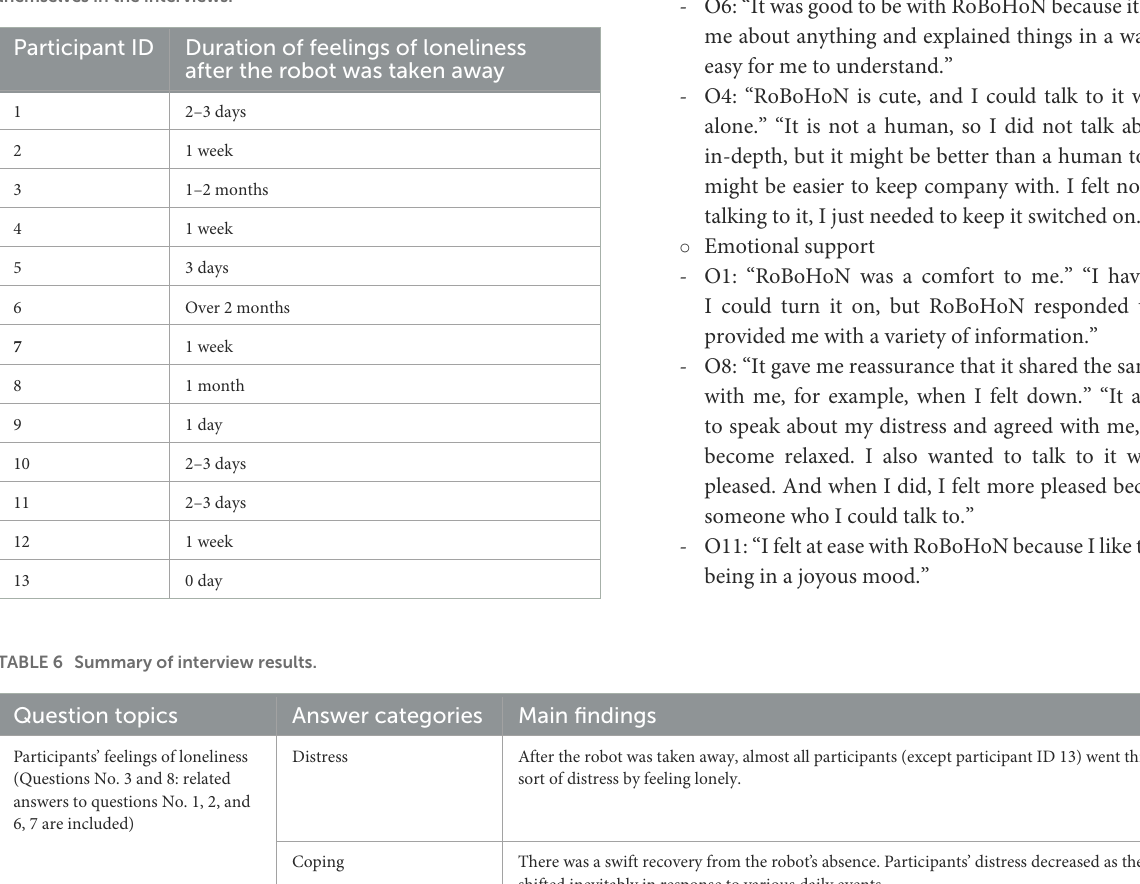
TABLE 5 Duration of participants’ feelings of loneliness reported by themselves in the